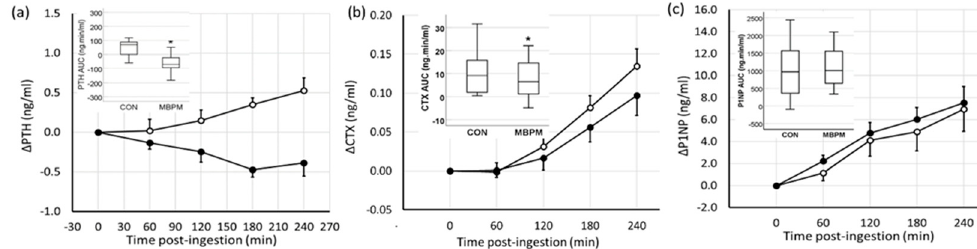
Figure 4. Temporal change in parathyroid hormone (PTH) and biomarkers of bone turnover following ingestion of CON (open circles) and MBPM (filled circles). ( a ) PTH, ( b ) C-terminal cross-linked telopeptide of type I collagen (CTX), and ( c ) P1NP. Data are the mean and SEM, n = 13. * denotes p < 0.05. Insert denotes the area under the curve, AUC 0-240.